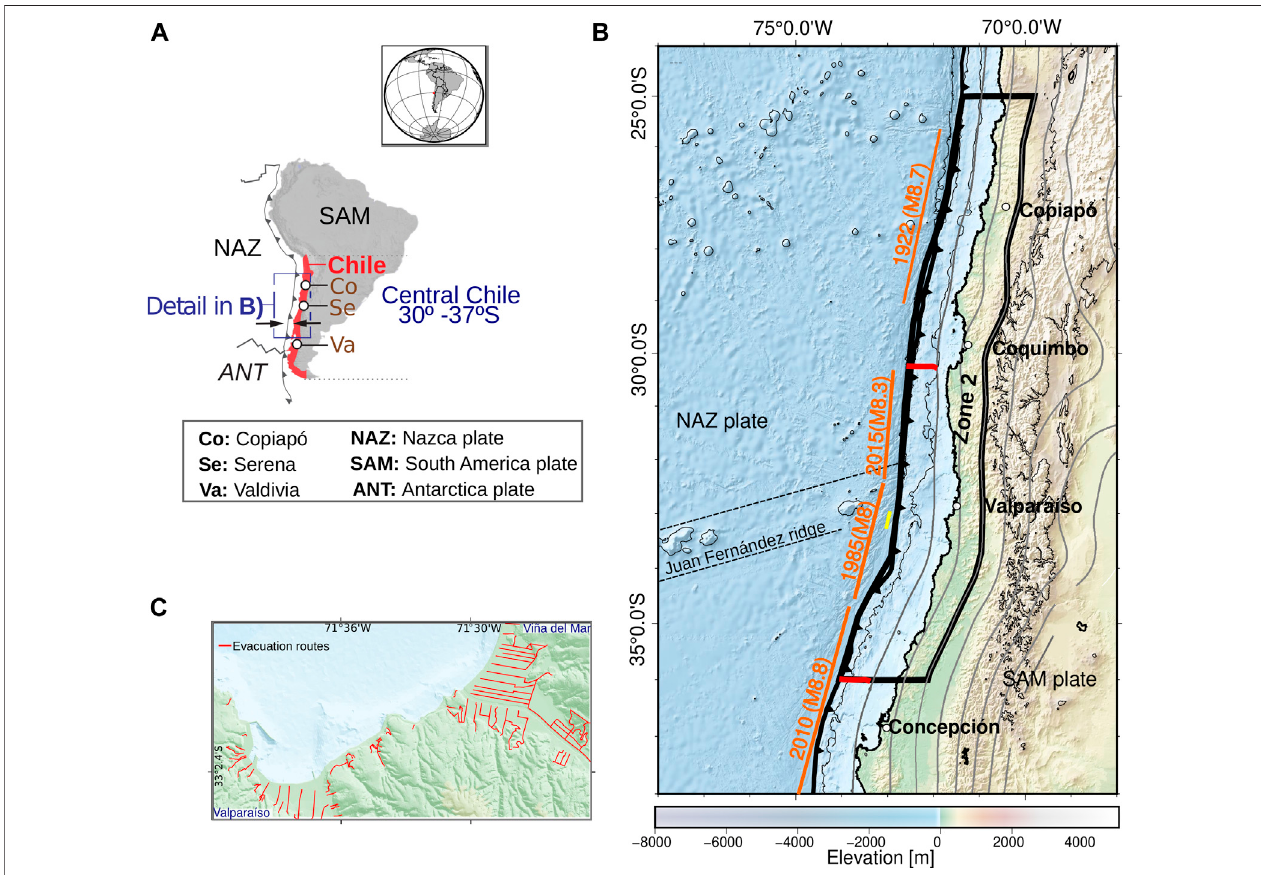
FIGURE 2 | Tectonic setting, seismic source zone and study area. (A) Regional map of South America showing the subduction zone formed between the Nazca andSouthAmericaplatesthatconvergeat6 – 7 cm/yr (B) Seismicsourcezone.TheblackpolygondemarcatestheZone2fromPoulosetal.(2019),where2,800seismic sources with stochastic slip distributions were generated. For reference, thin grey lines show Slab 1.0 depth contours every 20 km (Hayes et al., 2012). Orange lines showthealong-strikeextentofselectedearthquakerupturesfrom1900 – 2020,andthe1730ruptureestimated byCarvajaletal.(2017a)isshown inred (C) Digital elevation model of Valparaíso and Viña del Mar coastal cities. The red lines show the of fi cial tsunami evacuation routes.